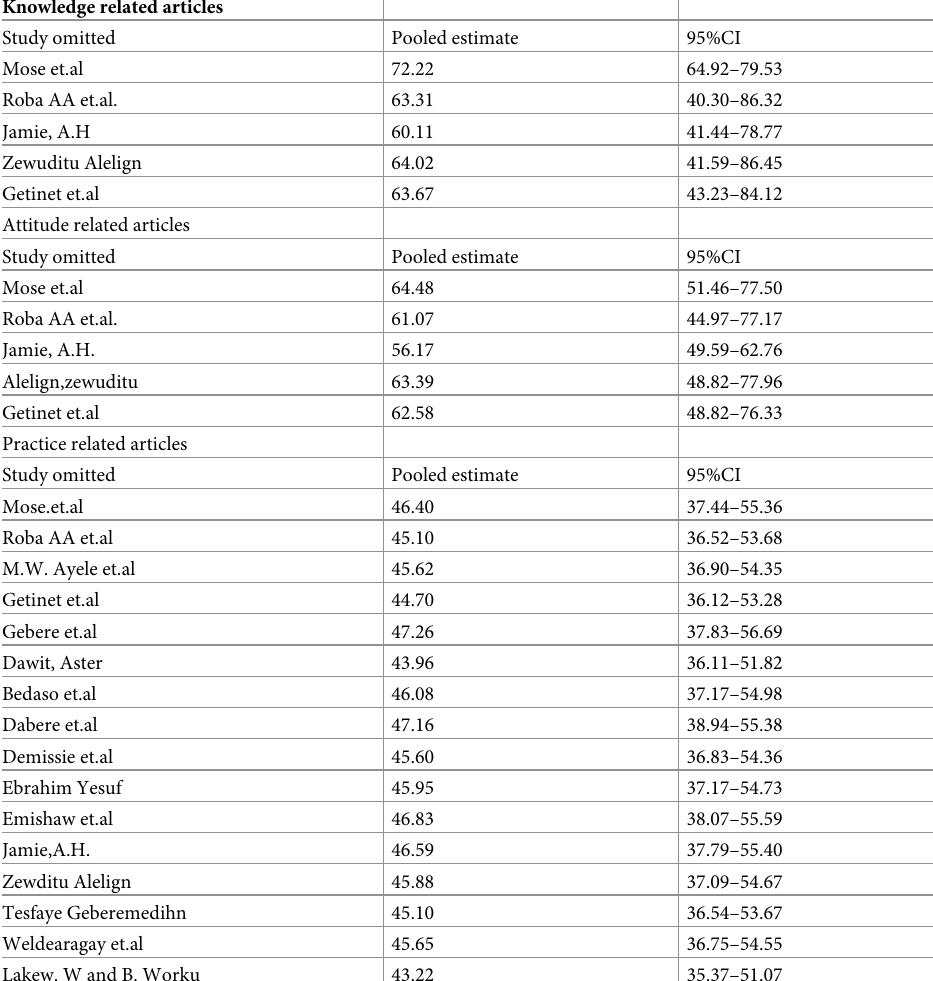
Table 2. A leave–out-one sensitivity analysis for knowledge, attitude, and practice of kangaroo mother care among postnatal women in